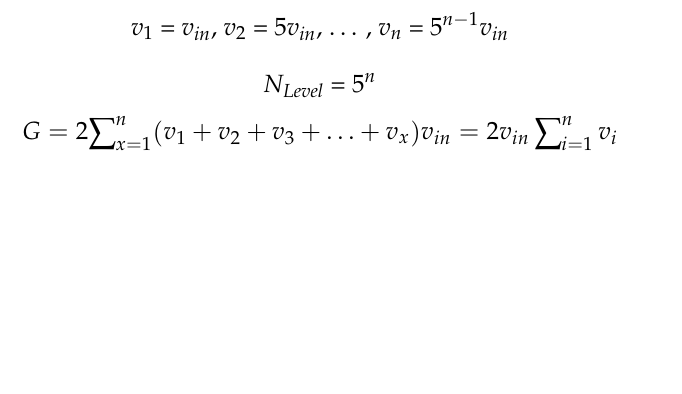
Figure 3. Pulse Width Modulation Scheme ( v tr1 ,v tr2 — Triangle carrier signal, v ref — reference signal, v con — constant signal, v max — maximum voltage, v— amplitude, t — time scale for one cycle (20 ms))